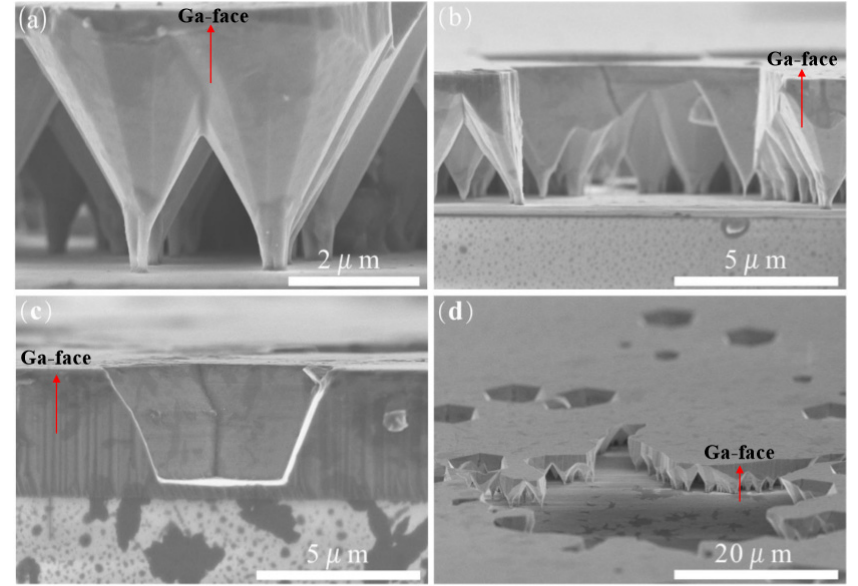
Figure 2. Cross-section SEM images of the MOCVD-grown GaN layer etched by phosphate for 14 min at 230 ◦ C. ( a ) The pyramid structures at the nitrogen polar (N-polar) face of MOCVD–GaN, ( b ) structures of GaN around the etch pit reach sapphire substrate, ( c ) the etch pit which does not reach sapphires substrate, and ( d ) a bird’s eye view image of the etched substrate.